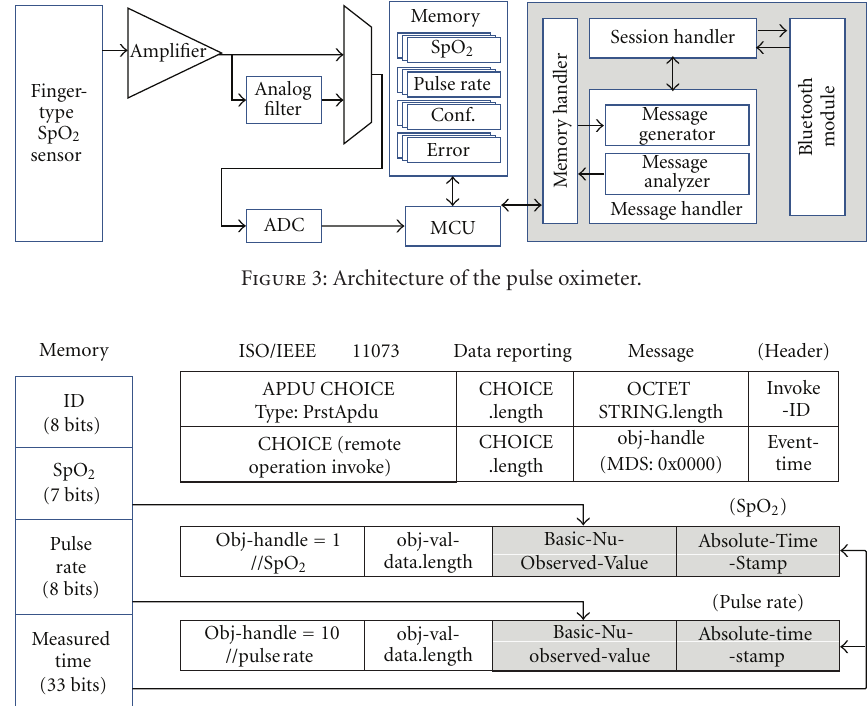
Figure 4: Process of message